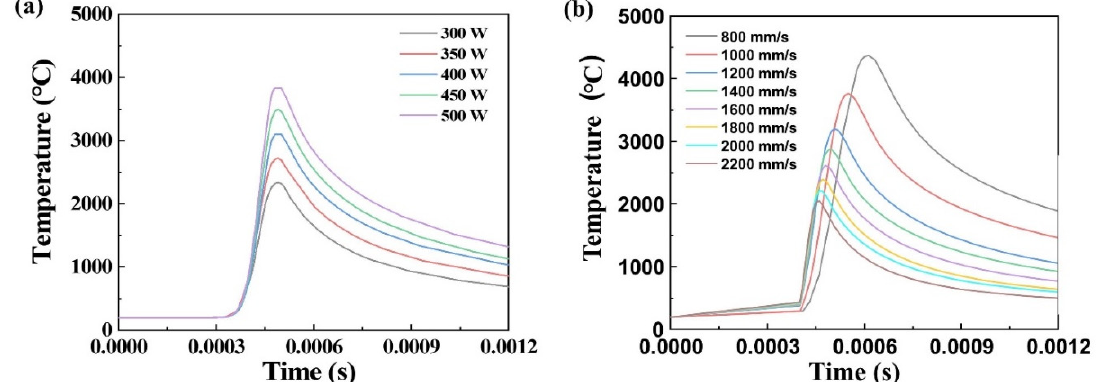
9 of 16 Figure 7. Melt pool temperature contours simulated with a laser power of 400 W and scanning speed of 1400 mm/s: ( a ) horizontal cross-section; ( b ) longitudinal cross-section. The maximum temperature of the melt pool is the most important prerequisite for the formability of parts fabricated by L-PBF. The CP-Ti powder cannot be melted below the melting point, which is 1668 °C, while recoil pressure resulting from the vaporization of the melted metal will be generated above the boiling point (3287 °C), which will lead to instability of the melt pools and the formation of defects such as keyhole porosity [6]. Therefore, the maximum temperature of the melt pool for the formable process parame- ters should be located between the melting point and boiling point. Furthermore, in the formable temperature intervals, the lower melt pool temperature could result in low-den- sity parts due to the balling effect and the lack-of-fusion pores. Figure 8 shows the tem- perature–time curves of the melt pools at point P as marked in Figure 1 for different pro- cess parameters. As shown in Figure 8a, at the same scanning speeds, the temperature of the melt pool increased as the laser power increased, which is attributed to the absorption of more heat. Figure 8b shows that, for the same laser power, the maximum temperature of the melt pool decreased with an increase in the scanning speed, and the moment when